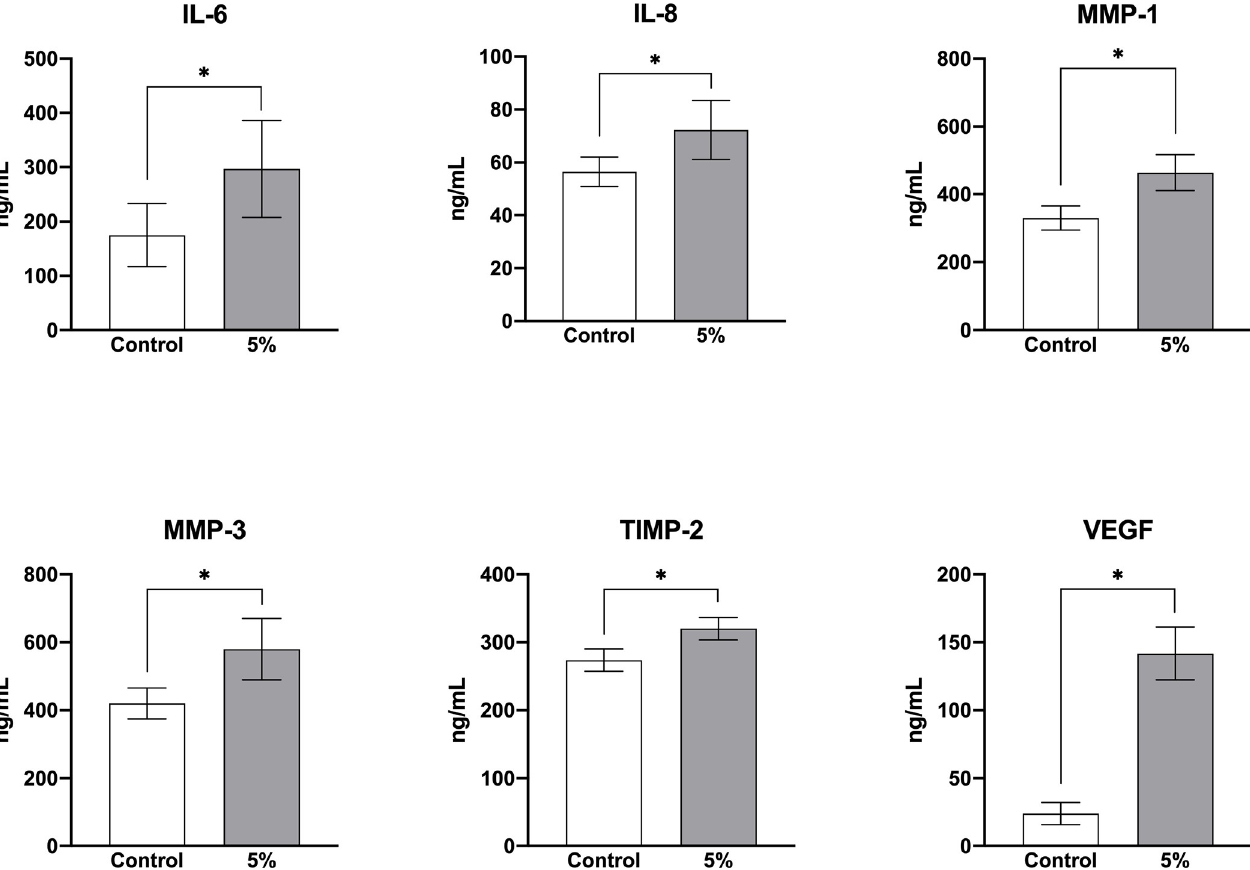
Fig 7. Factors released in control versus 5% MSS. IL-6, IL-8, VEGF, MMP-1, MMP-3, and TIMP-2 release from ligamentum flavum cells loaded with MSS at 5% for 24 h was significantly increased compared to the control group.